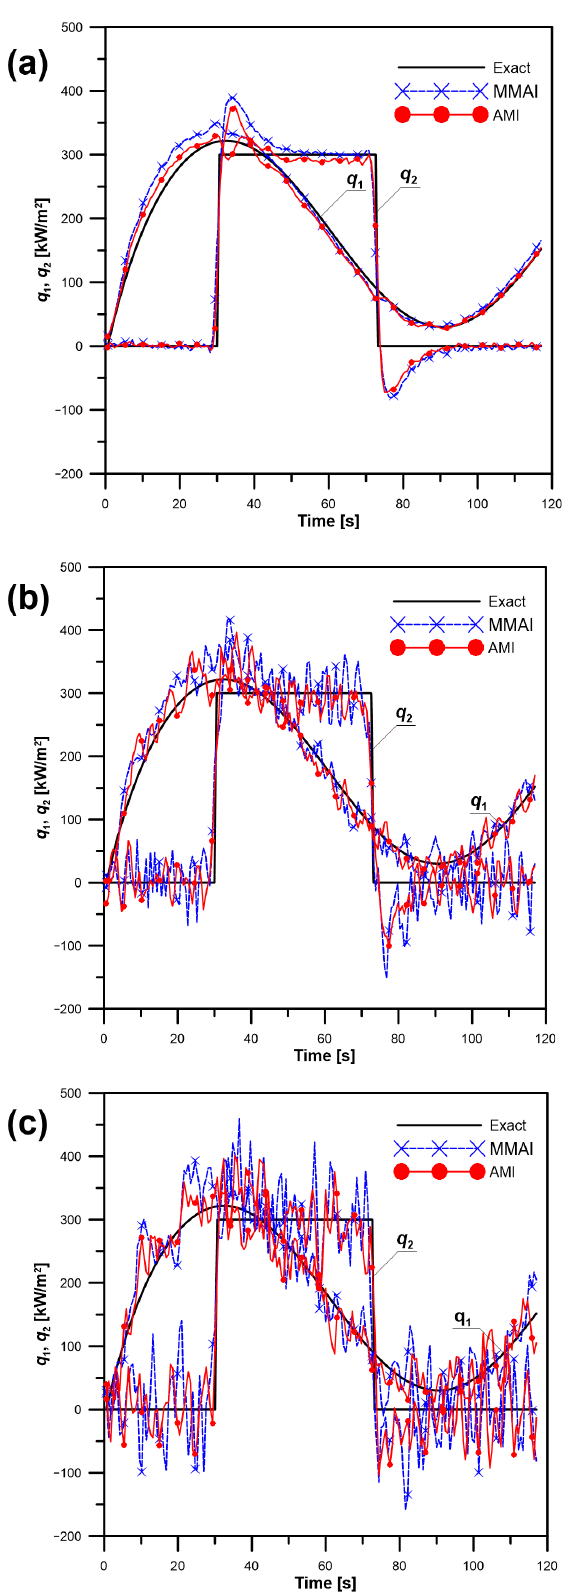
Figure 9. Comparison between exact heat fluxes and those calculated by the MMAI and the AMI method for measuring errors: σ = 0.001 ( a ), σ = 0.03 ( b ), σ = 0.05 ( c ).